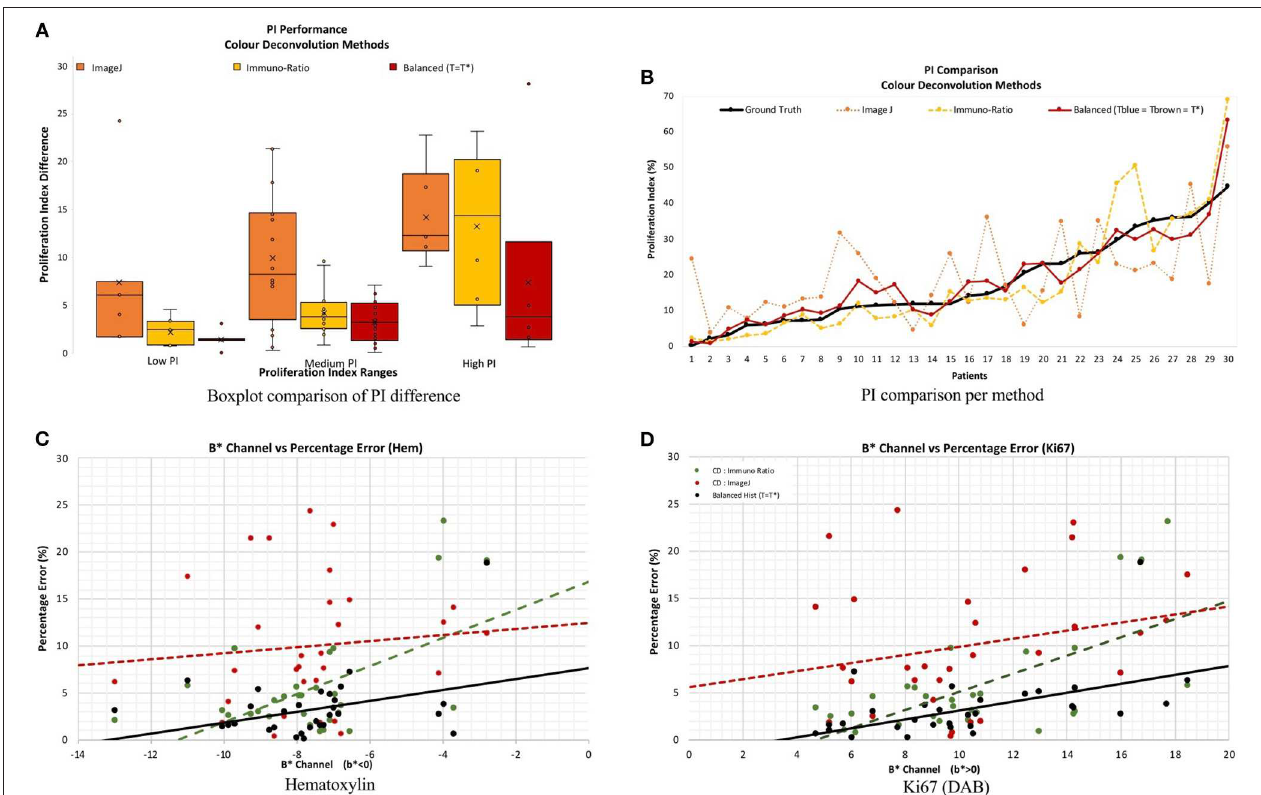
FIGURE 11 | (A,B) PI difference and PI estimate comparison of all methods, including manual, ImageJ and Immuno-Ratio methods and balanced histogram ( T = T *). (C,D) Percentage error in relation to the b * Channel within the L * a * b * Color space per stain, Hematoxylin (A,C) and Ki67 ( + DAB) (B,D)